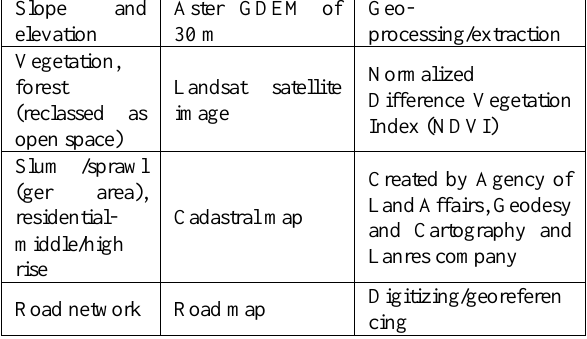
Table 3. Data sources used for the study Source: Myagmartseren et al., 2018